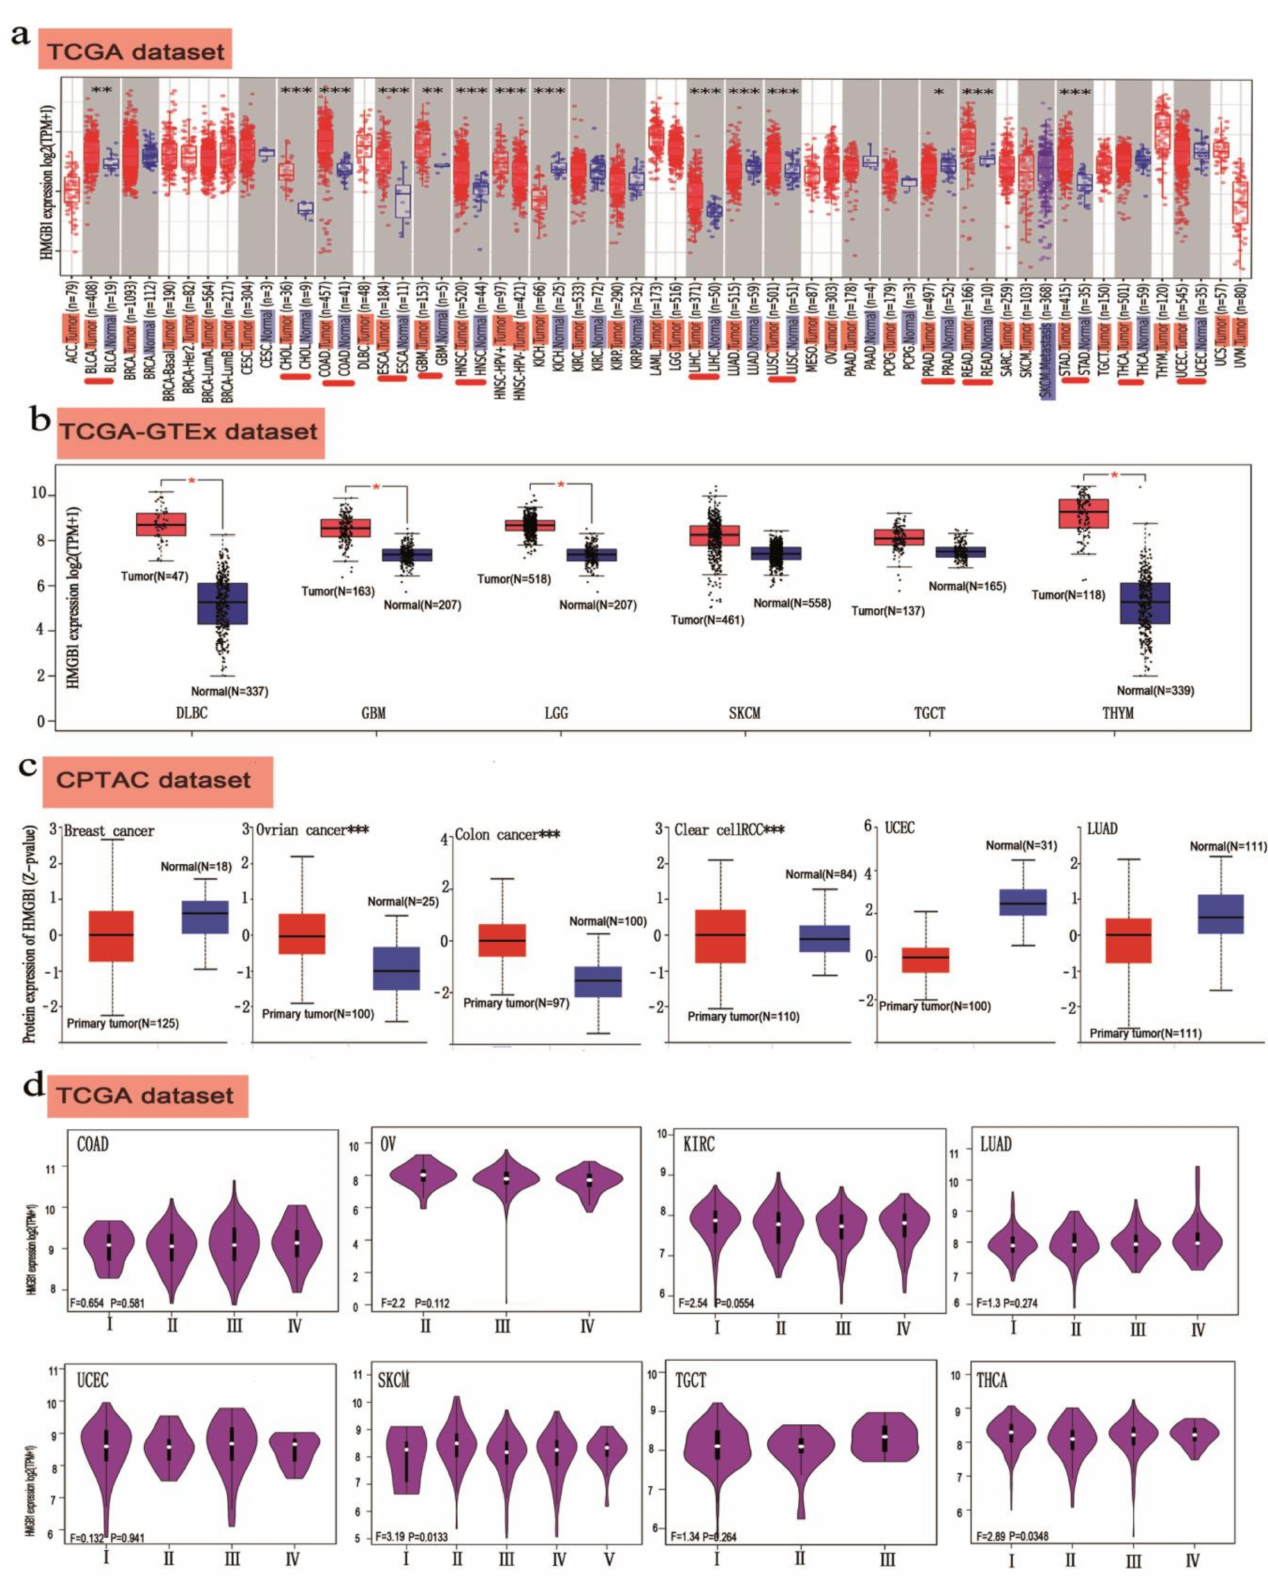
Figure 2. High expression levels of HMGB1 gene in different cancers and at various pathological stages. ( a ) HMGB1 expression status in different cancers or specific cancer subtypes was explored, according to TIMER2.0 approach in the TCGA dataset. ( b ) Boxplot data of DLBC, GBM, LGG, SKCM, TGCT and THYM in GTEx. ( c ) Breast cancer, ovarian cancer, colorectal cancer, clear cell RCC,